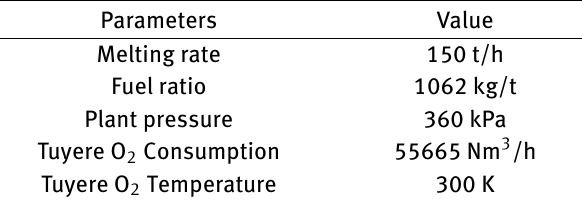
Table 4: Operating parameters of melter gasifier considered [20–23] Parameters